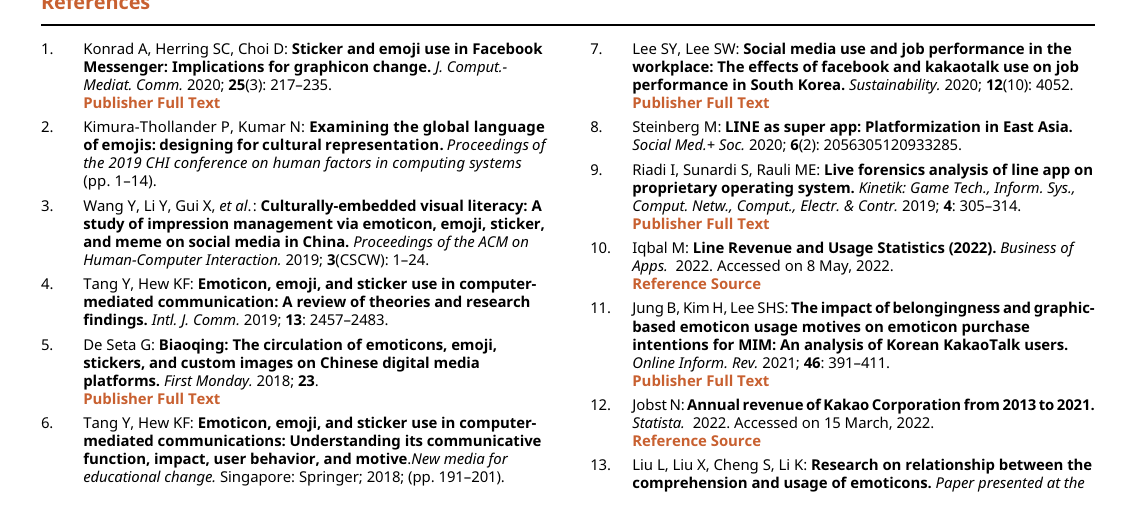
Figshare: Paid sticker article datasets. https://doi.org/10.6084/m9.figshare.19964480.v5. 63